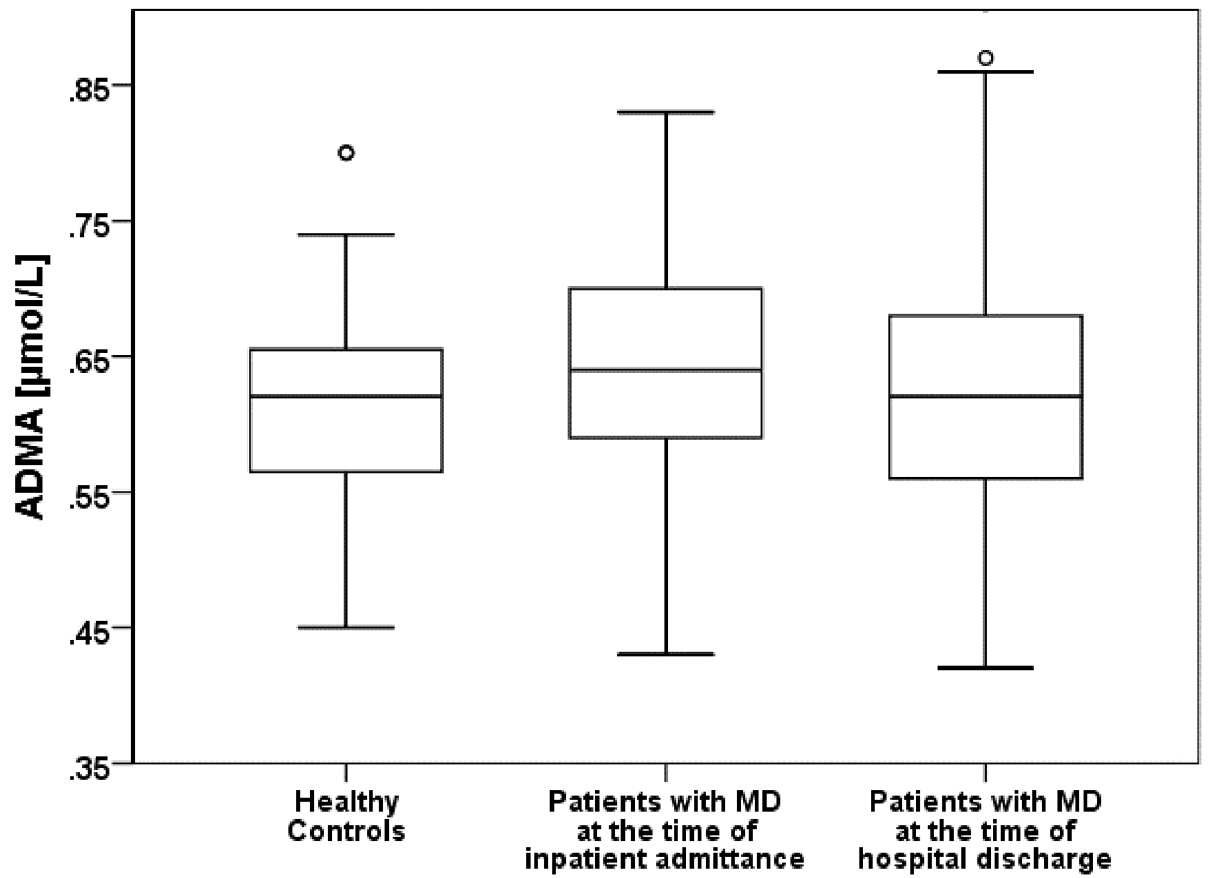
Fig 3. Comparison of Asymmetrical Dimethylarginine (ADMA) between healthy contols and patients with major depression (MD).